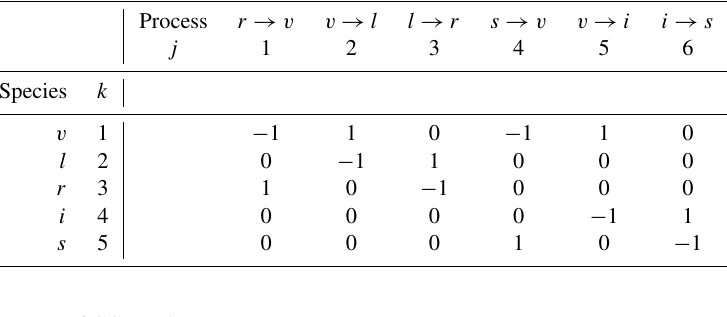
Table 1. Variables λ kj for the system of CGTBT07.